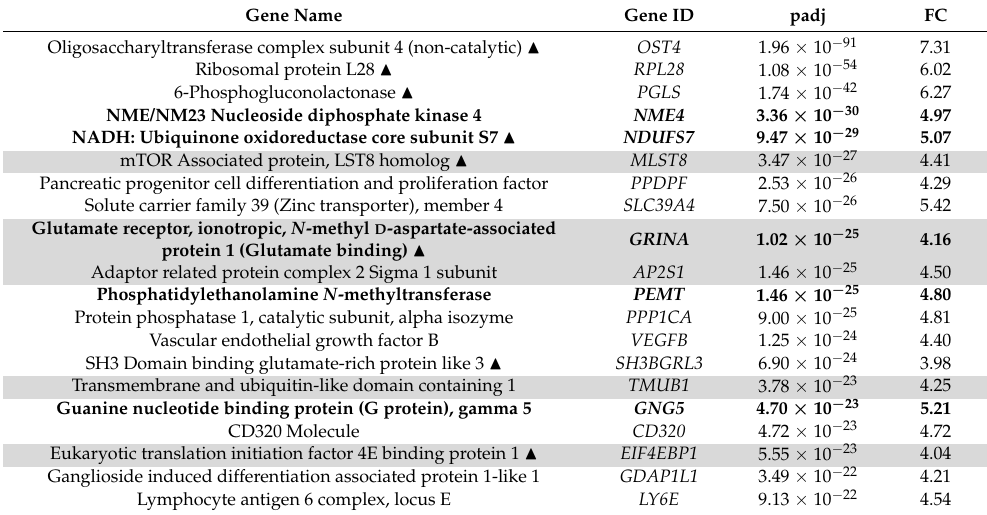
Abbreviations: NME, non-metastatic cell expressed; NADH, nicotinamide adenine dinucleotide; mTOR, mammalian target of